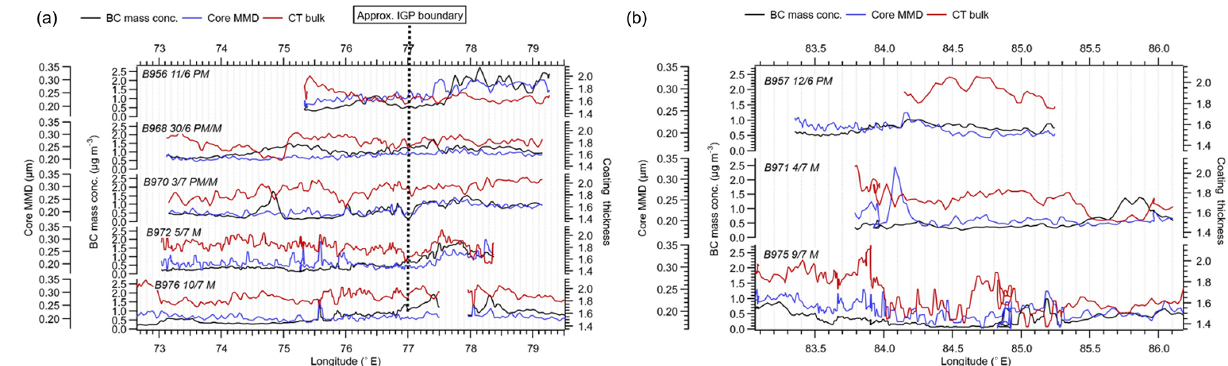
Figure 4. Horizontal spatial BC physical properties for pre-monsoon (PM) and monsoon (M) seasons in northern India, from LKN to JAI– JOD (a) and from LKN to BBA (b) . The plots highlight the IGP region (77 ◦ E) and outside the IGP (73–77 ◦ E) separated by the vertical black dashed line. The monsoon progression is indicated by the blue shaded